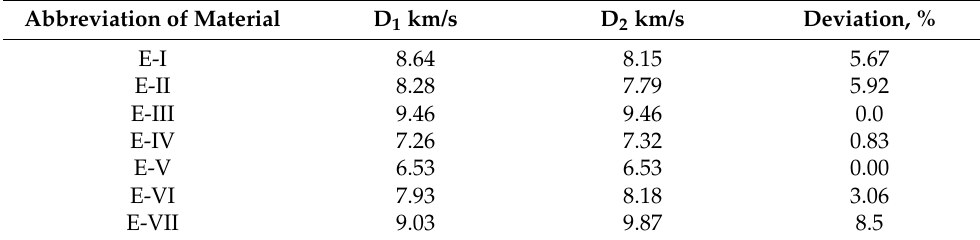
Table 3. The detonation velocity obtained.